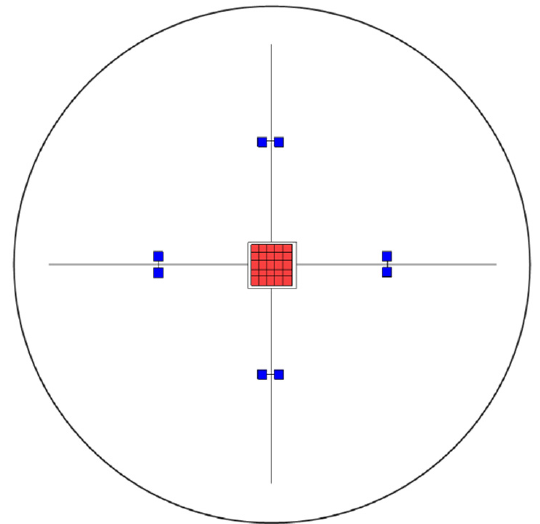
Figure 1. Schematic image of the non-nutrient agar E. coli plate (black). Bright-field images were taken with a Leica DMI4000 B microscope after 1 and 3 weeks with a 10-fold objective and 8-fold magnification changer. Twenty-five images were taken from the center (red squares) and eight images from the periphery (blue squares, 1.5 cm distance from the central images and 1.5 mm between the peripheral images along the drawn line) of each plate at each time point.